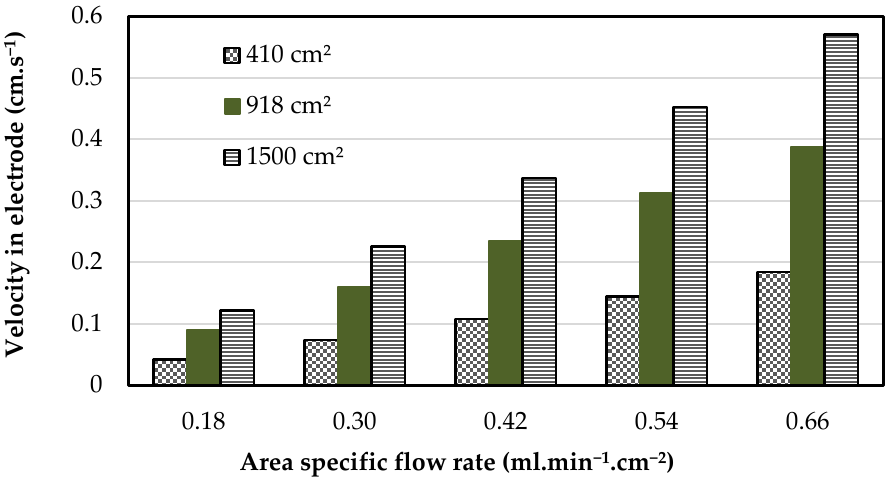
Figure 2. Predicted electrolyte velocity in the electrode over the cell areas 410, 918 and 1500 cm 2 .